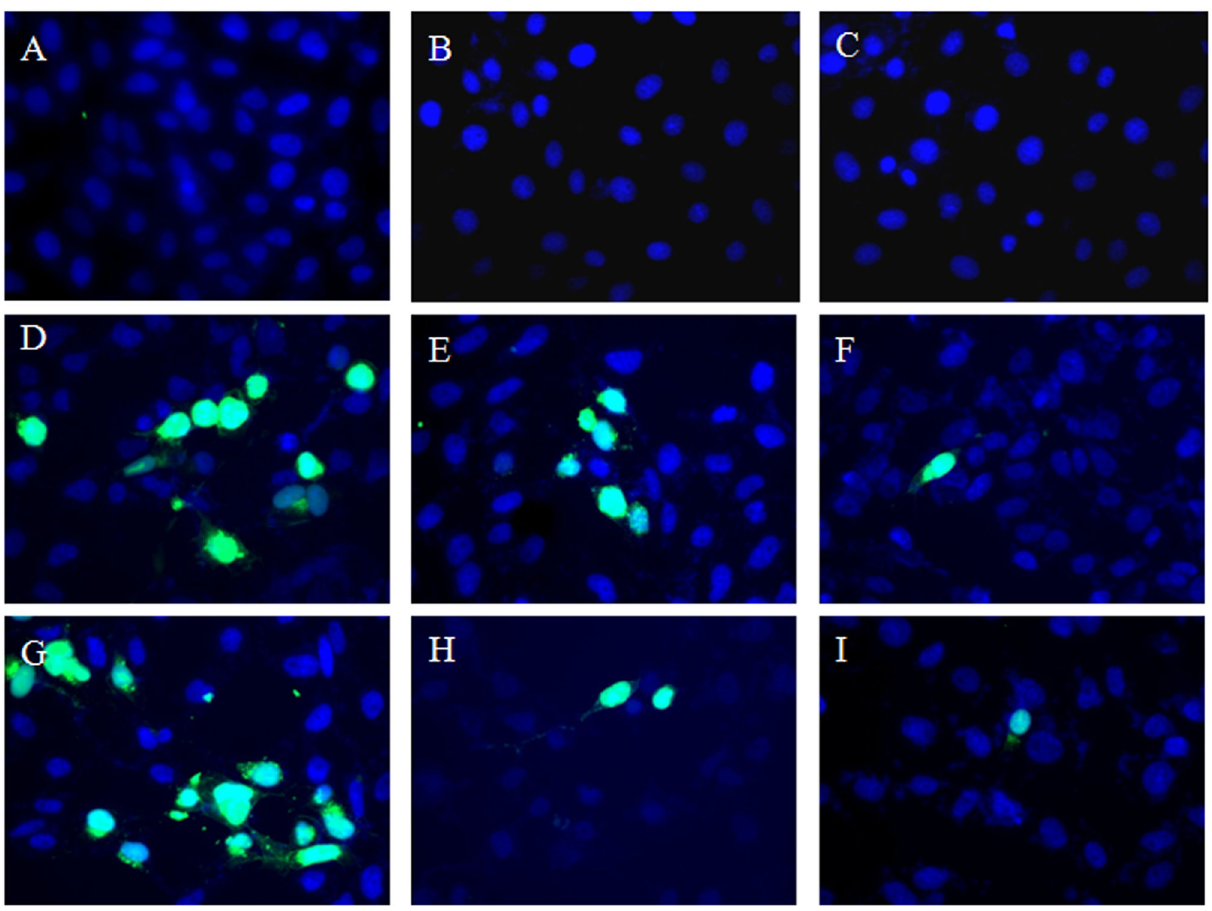
Figure 2. Immunofluorescence studies of HSV-2 infected cells treated with HM. Cells treated with HM at 2-4 h post-infection (p.i) were fixed with paraformaldehyde and blocked with BSA-PBS-triton X100 solution. After permeabilization, cells were incubated with FITC-labelled polyclonal rabbit anti-HSV-2 antibody, and observed under Axio Imager M1 (Carl Zeiss, NY, USA) inverted epifluorescence microscope. Cell Control [a]; Cells treated with HM (5.0 μg/ml) at 2 h [b] and 4 h [c] p.i.; Virus control at 2 h p.i [d]; infected cells treated with HM at 1.5 μg/ml [e], and 5.0 μg/ml [f] at 2 h p.i; Virus Control at 4 h p.i [g]; infected cells treated with HM at 1.5 μg/ml [h] and 5.0 μg/ml [i] at 4 h